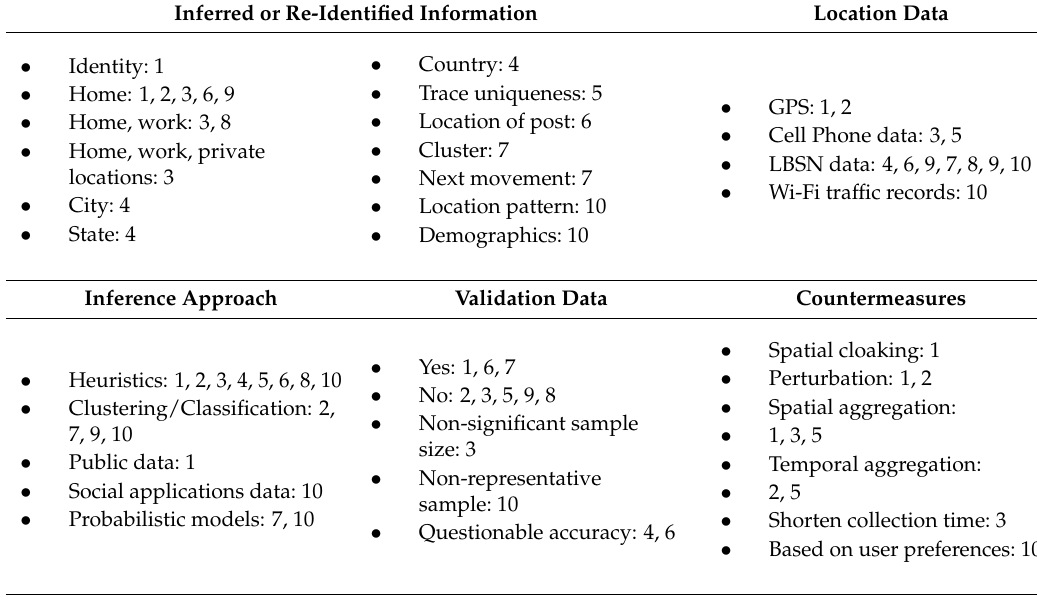
Table 1. Literature review on re-identification and inference attacks from location